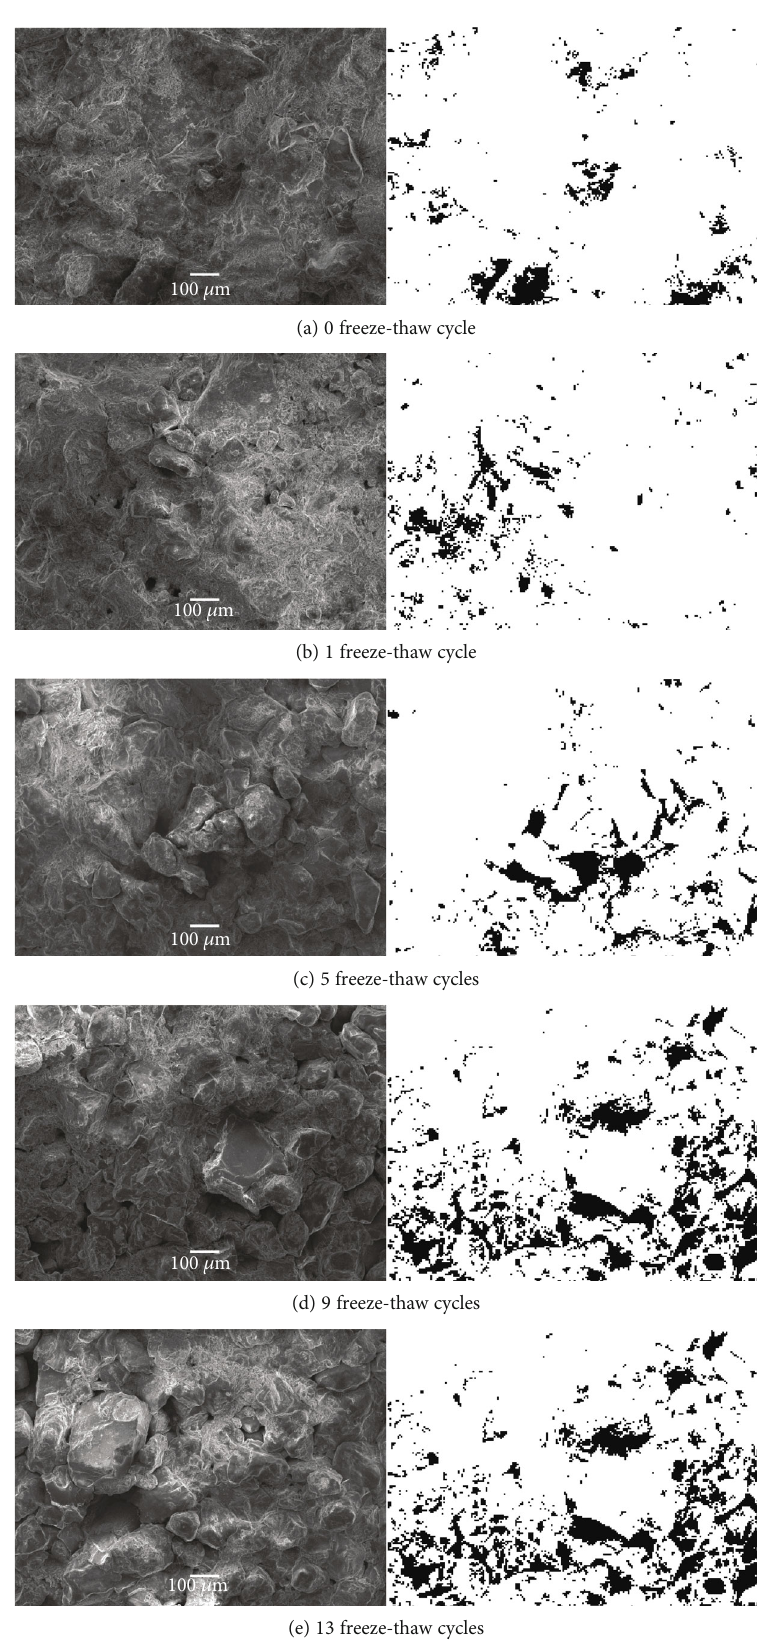
Figure 6: SEM and binary images of red sandstone after (a) 0, (b) 1 (c) 5, (d) 9, and (e) 13 numbers of freeze-thaw